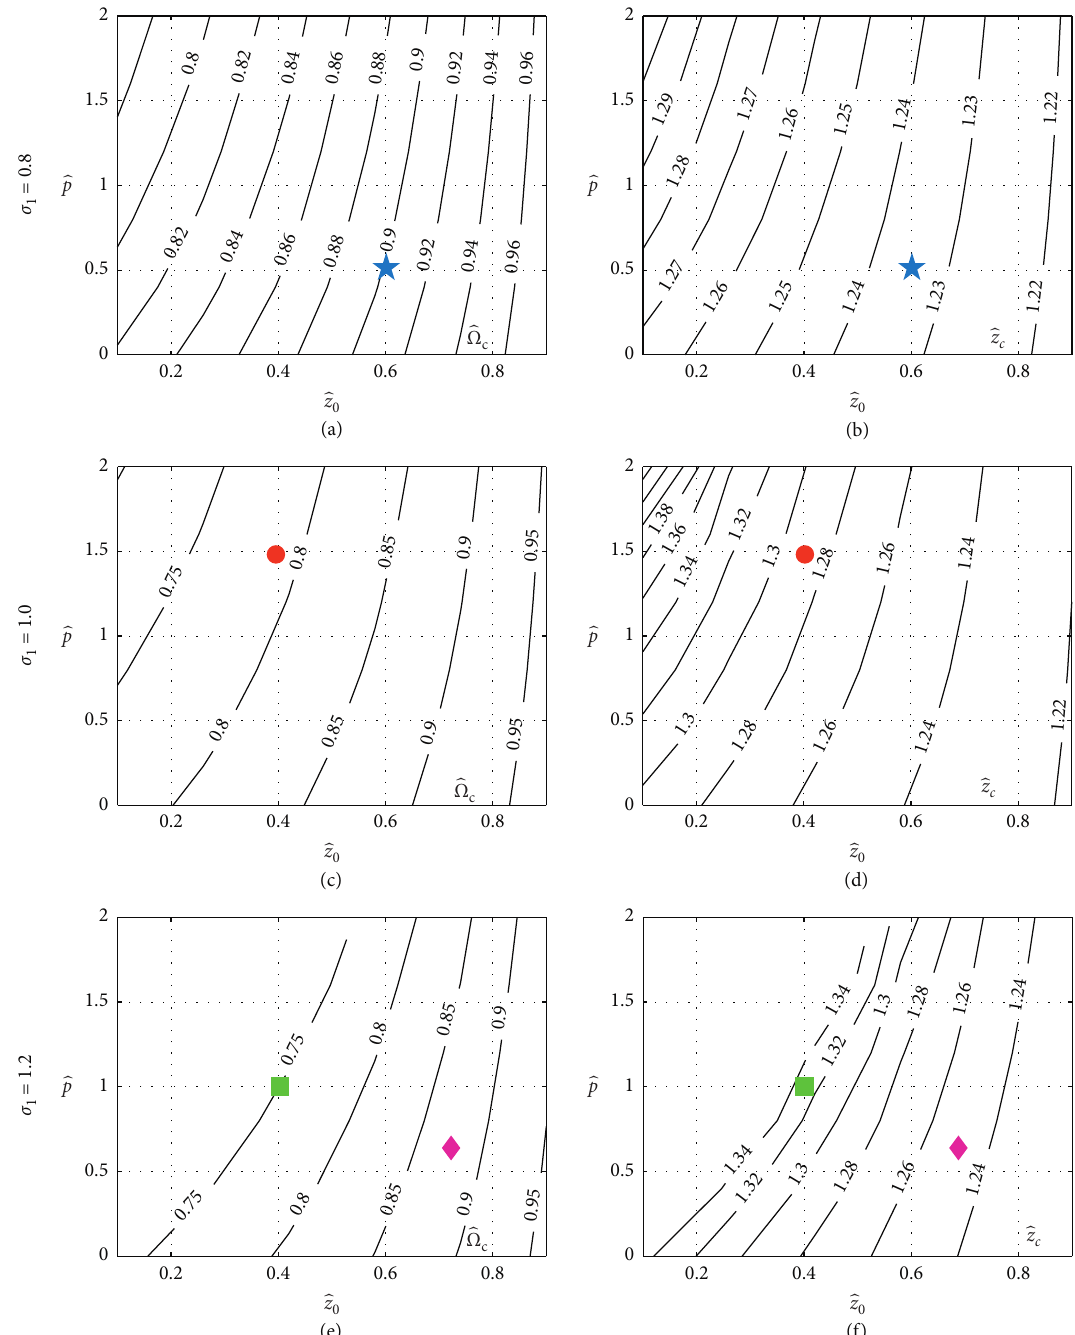
􏽢 Z Figure 10: Contour plots for the design of an X -shaped suspension with QZS behaviour at large deflections: values of Ω C and C on the , 􏽢 z , and 􏽢 p backbone curve for different combinations of σ 1 0 lines in the FRCs of Figure 13. For validation purposes, system parameters indicated by the markers in Figures 5 and numerical solutions are indicated by circles, and they are 6. The FRCs of the system are solved in closed form from the obtained by direct integration of the equation of motion of amplitude-frequency equation reported in equation (13), the system, where the exact expression for the static spring which is quadratic in Ω 2 , and with damping ratio deter- restoring force from equation (2) is used. In the case where a mined according to equation (20). The stability of the steady- multistable solution is expected, different initial conditions state solutions is calculated by applying Floquet theory as were selected to validate the response on both the lower and detailed in [21] so that stable solutions are represented by higher amplitude branches of the frequency response curve. solid lines and unstable solutions are represented by dashed